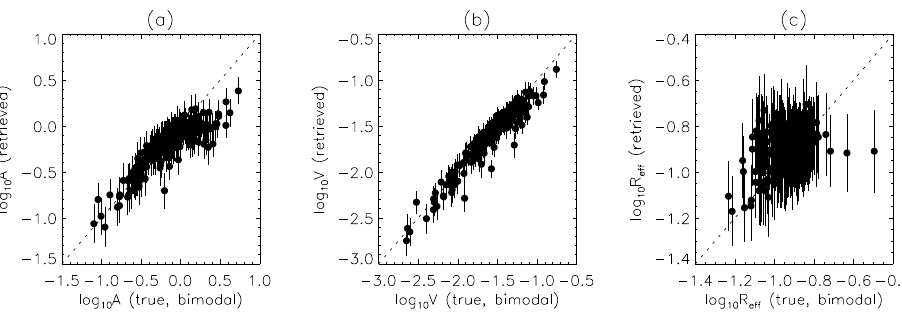
Fig. 7. Integrated monomodal aerosol properties as retrieved from bimodal background aerosol in comparison with the correct bimodal surface area densities (a) , volume density (b) and effective radius (c) . The linear correlation coefficients are 0.87 in A , 0.96 in V and 0.38 in R eff (significant at p > 0 . 05% , Taylor (1939, Table C).